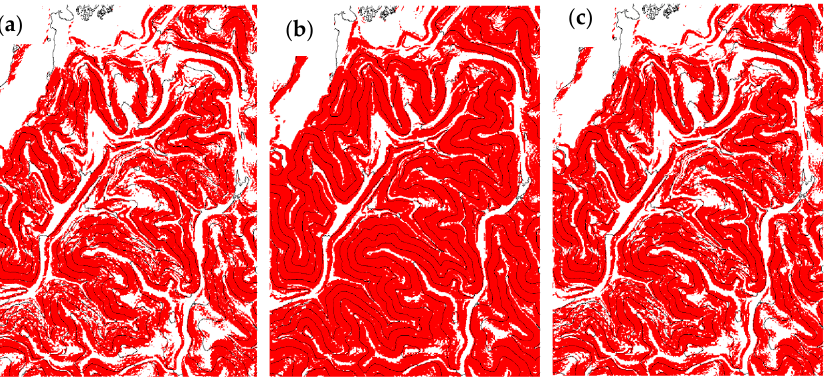
Figure 9. Changes in unstable grids calculated for the forest basin with 284,204 grids in total under fully saturated conditions with the weight of stems ( a ) just after clear-cutting (number of unstable grids: 163,720), ( b ) 10 years after clear-cutting and new planting (number of unstable grids: 216,606), and ( c ) 20 years after new planting (number of unstable grids: 178,157).